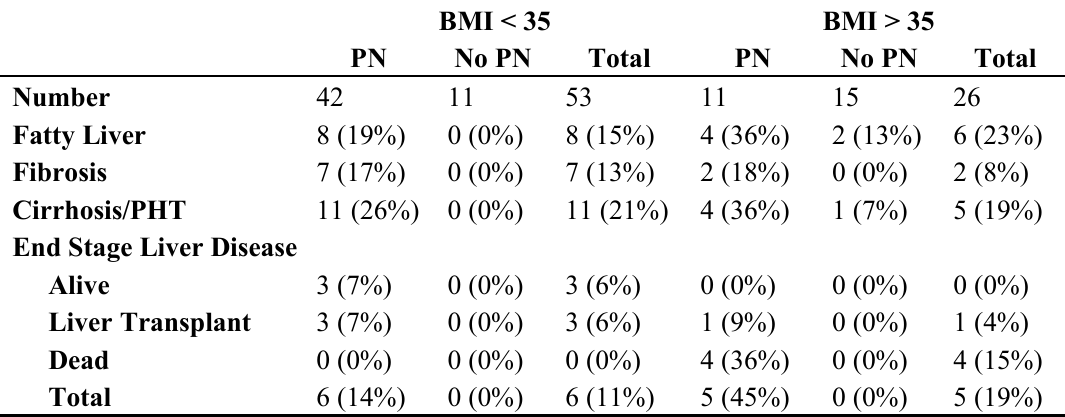
Table 6. Liver disease and its